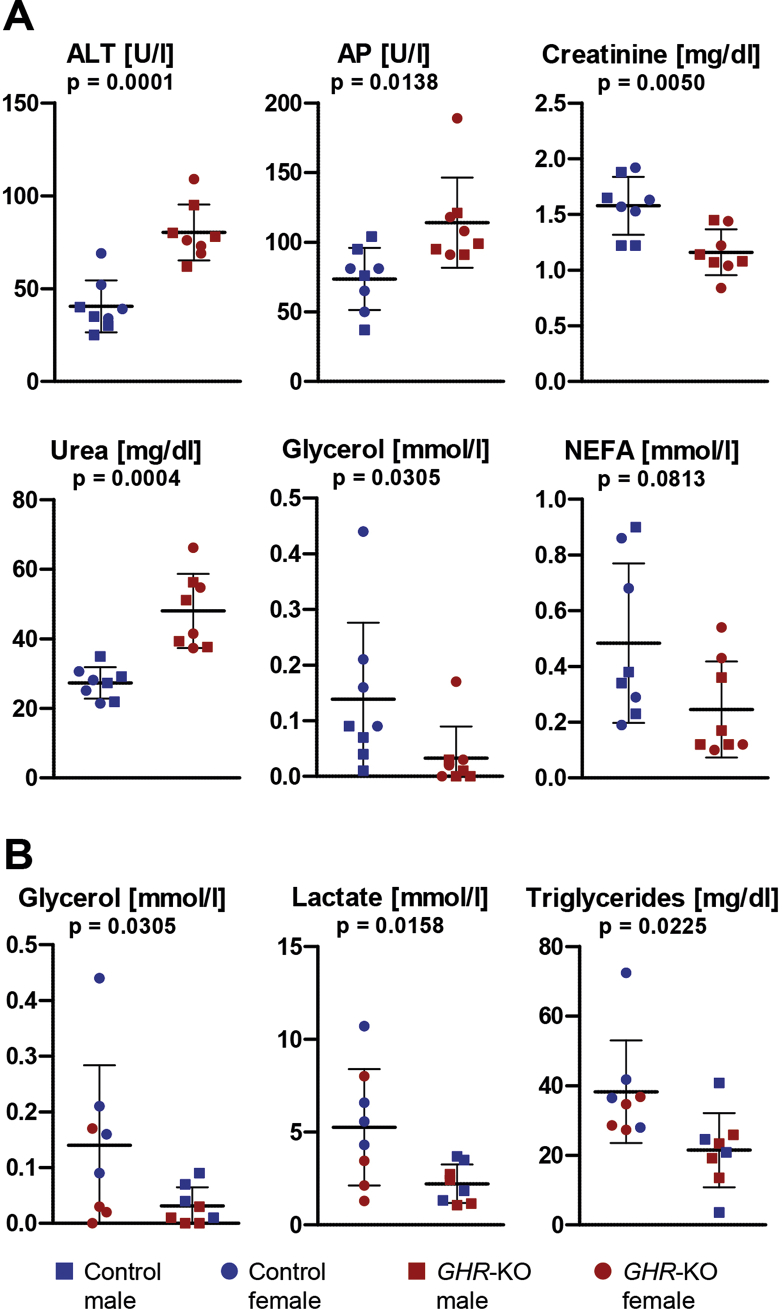
Clinical-chemical parameters in serum. A: Parameters affected by group. B: Parameters affected by sex. Horizontal lines represent mean and SD. ALT = alanine aminotransaminase, AP = alkaline phosphatase, NEFA = non-esterified fatty acids.